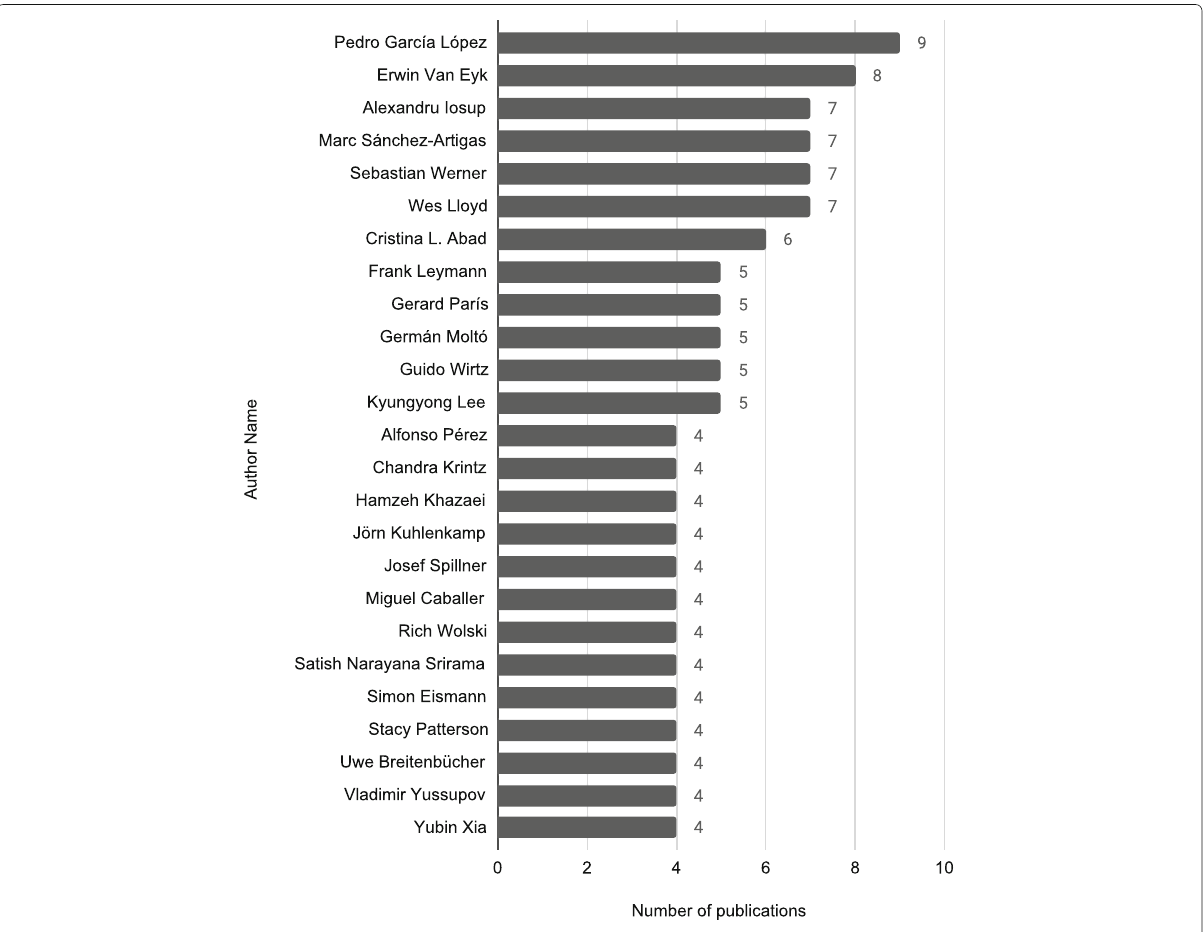
Fig. 7 Active researchers based on the published papers